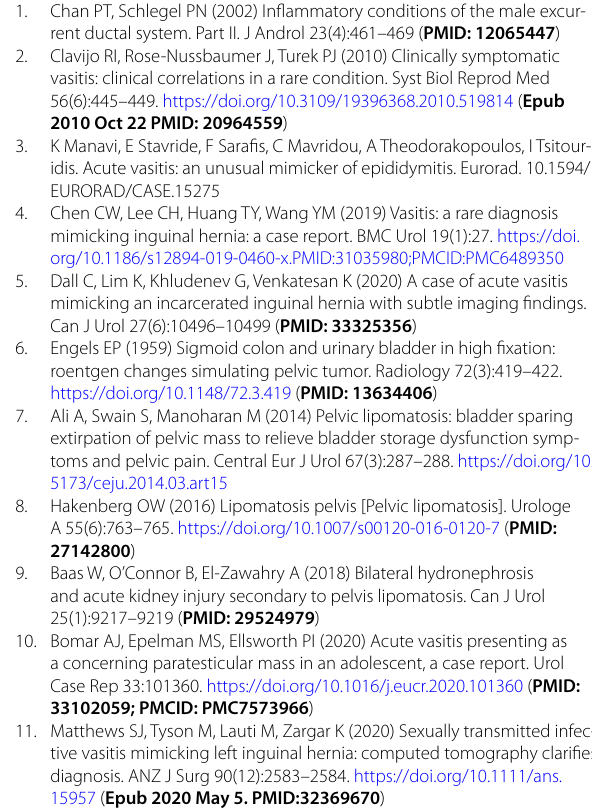
Fig. 3 Axial MRI pelvis showing extensive pelvic lipomatosis with bilateral dilated vas. The diameter of dilated right vas was 0.67 cm and left vas was 1.01